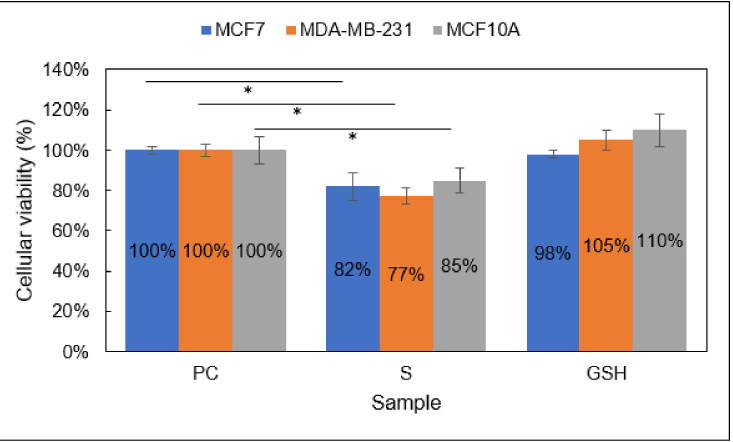
Figure 2. Cellular viability of MCF7 (blue), MDA-MB-231 (orange), and MCF10A (gray) cells analyzed with the MTT assay. Sample groups include: PC (untreated), S (Group 1), and GSH (functional control) cells. Data points represent the mean ± standard deviation. Statistical differences from the positive control are signified by * p <